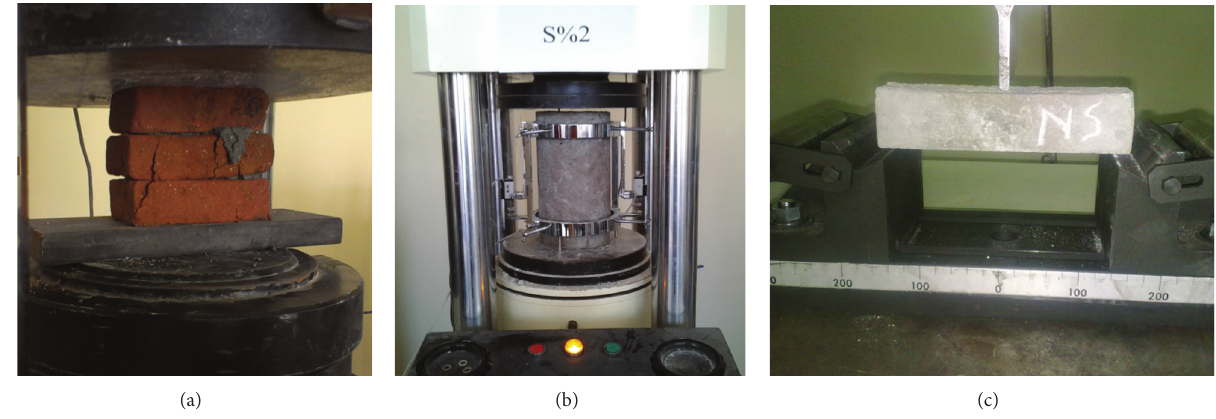
Figure 3: The experiments prepared of mechanical properties of bricks and